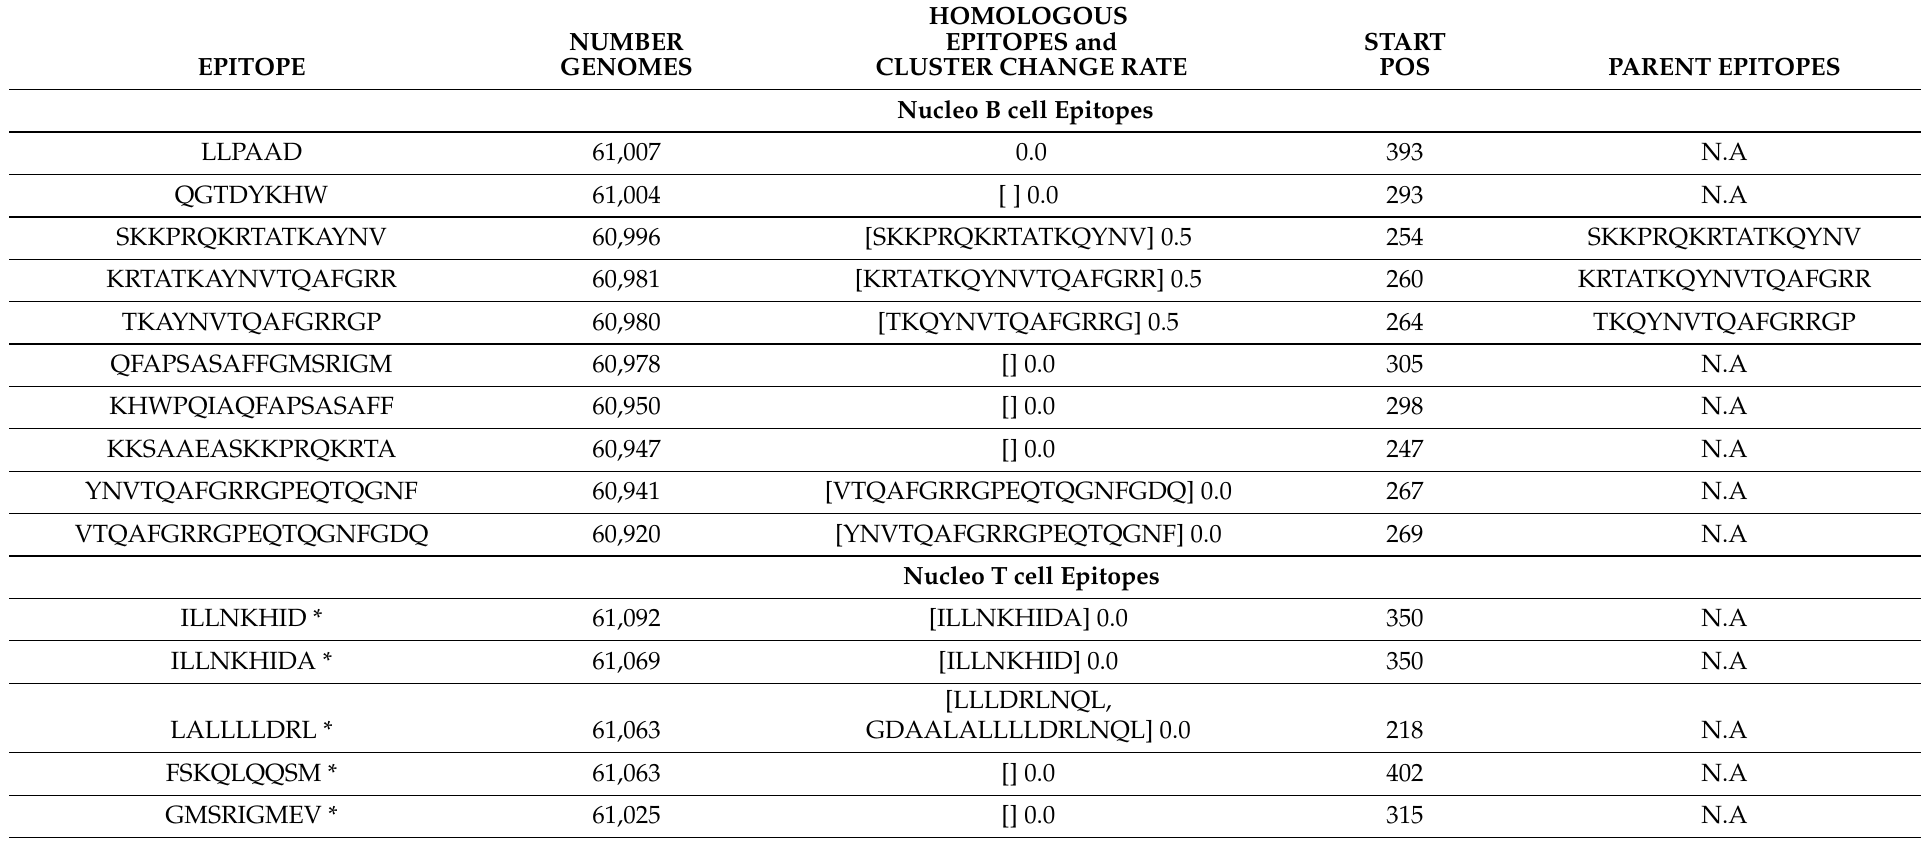
Table 2. Top 10 most commonly found epitopes in Nucleoprotein. Here, frequency of occurrence is determined by calculating the number of unique genomes an epitope is present in. Homologous epitopes are sister epitopes that cluster together with the epitope in first column when performing clustering by sequence. The cluster change rate indicates the probability of a candidate epitope being found in the cluster. If the cluster consists of only lab confirmed epitopes, the evolution rate will be 0. Start pos is the index of the starting position of epitope on aligned protein sequences, as noted in Section 2.8.1 and in case of every epitope matches the median start position on unaligned sequences. * in front of the sequence indicates that the sequence was found to be a MHC CLass I epitope in majority assays listed on